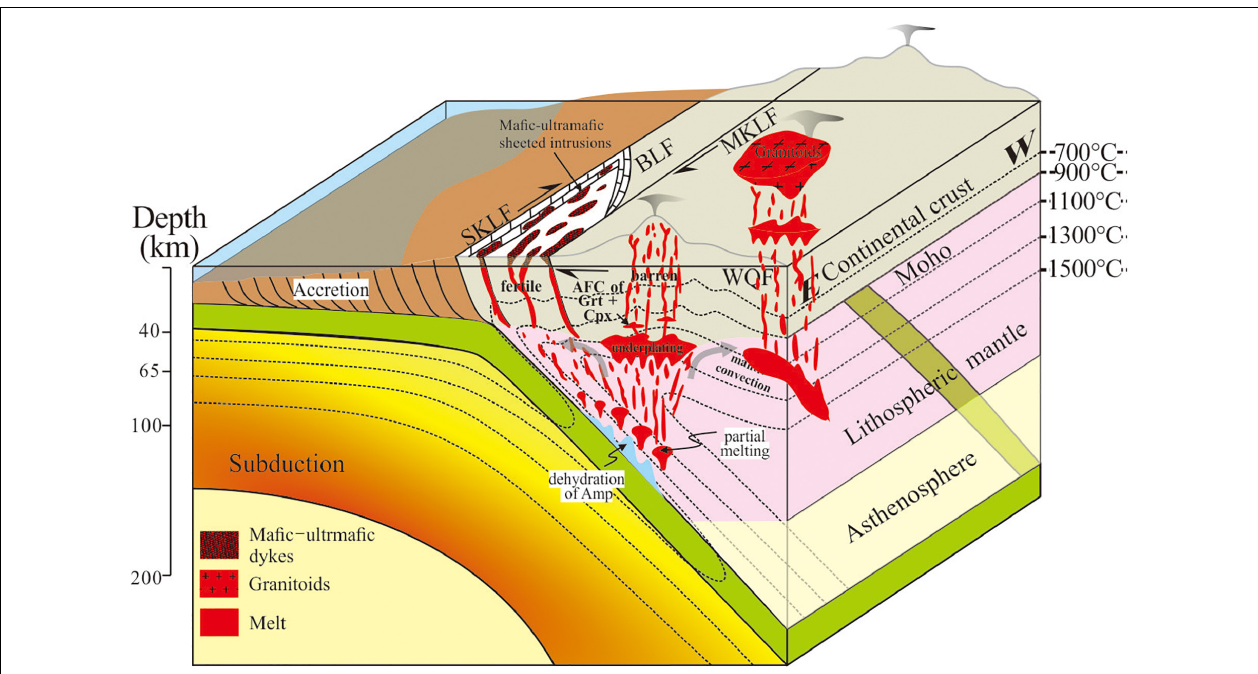
FIGURE 12 | Schematic diagram showing the tectonic evolutionary history of the Permian ultramafic–mafic complex and the corresponding mineralization of the East Kunlun Orogenic Belt. For explanation see text.